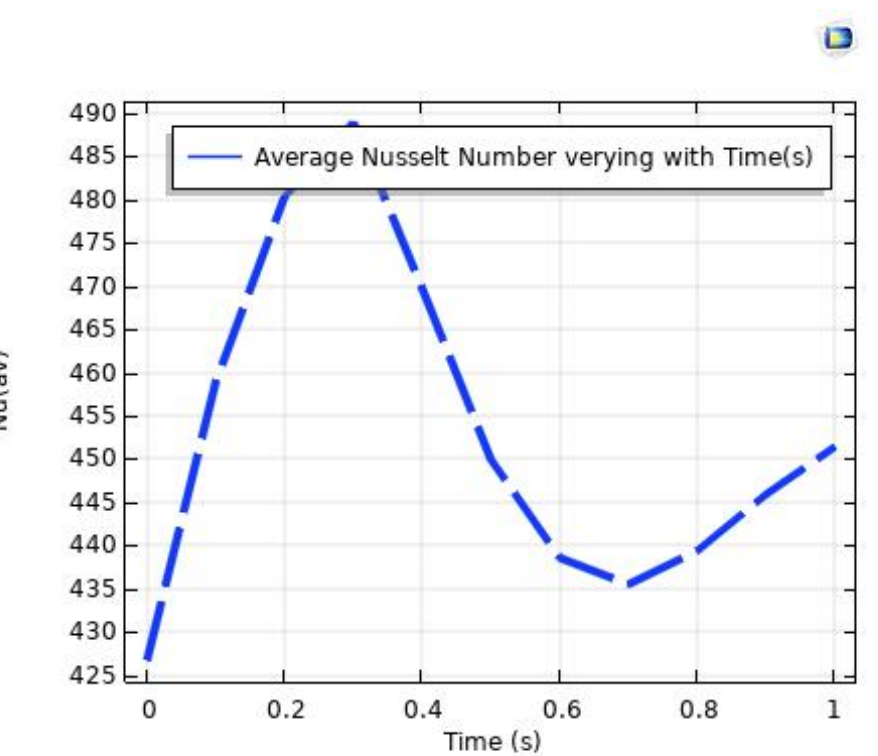
Figure 23. The Nusselt number variation with time. Table 4. The thermophysical properties of the blood base fluid and the silver and gold nanoparti- cles [16].